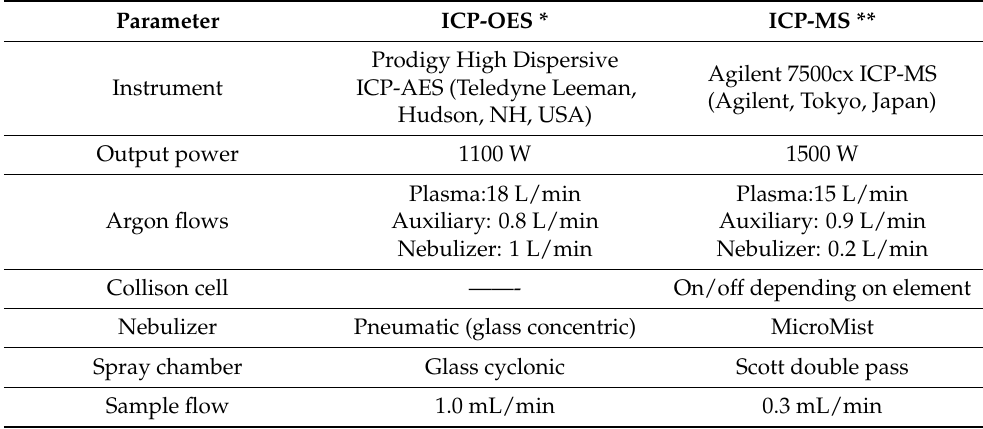
Table 1. Instrumental conditions of the analytical methods used in the present